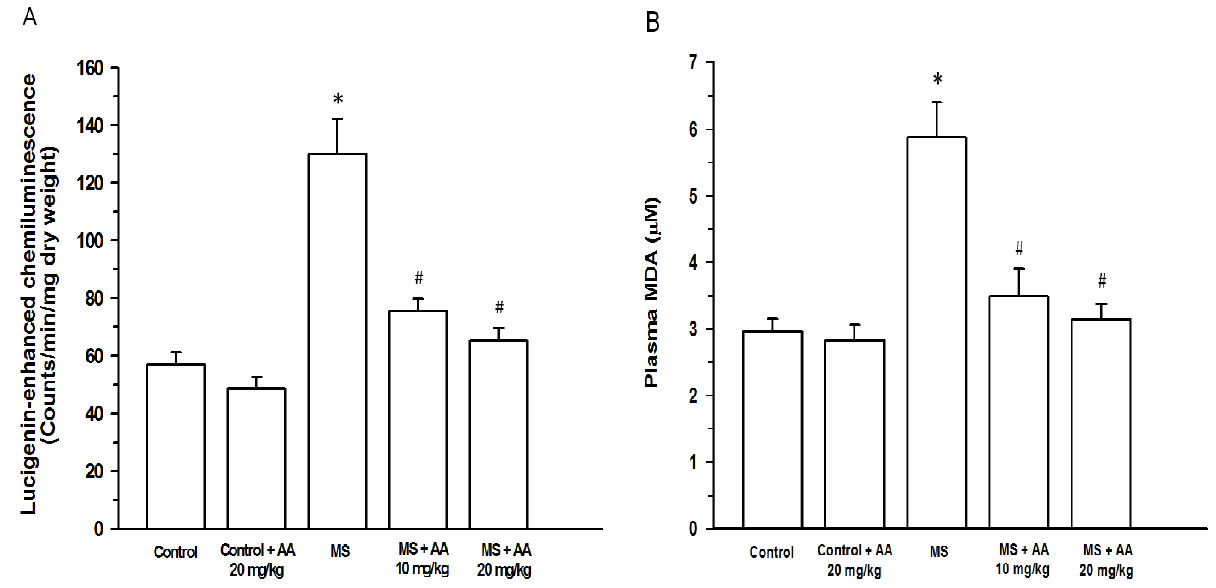
Figure 3. Effect of asiatic acid on vascular superoxide production ( A ) and plasma MDA ( B ) in all experimental groups. Results are expressed as mean ± SEM. AA